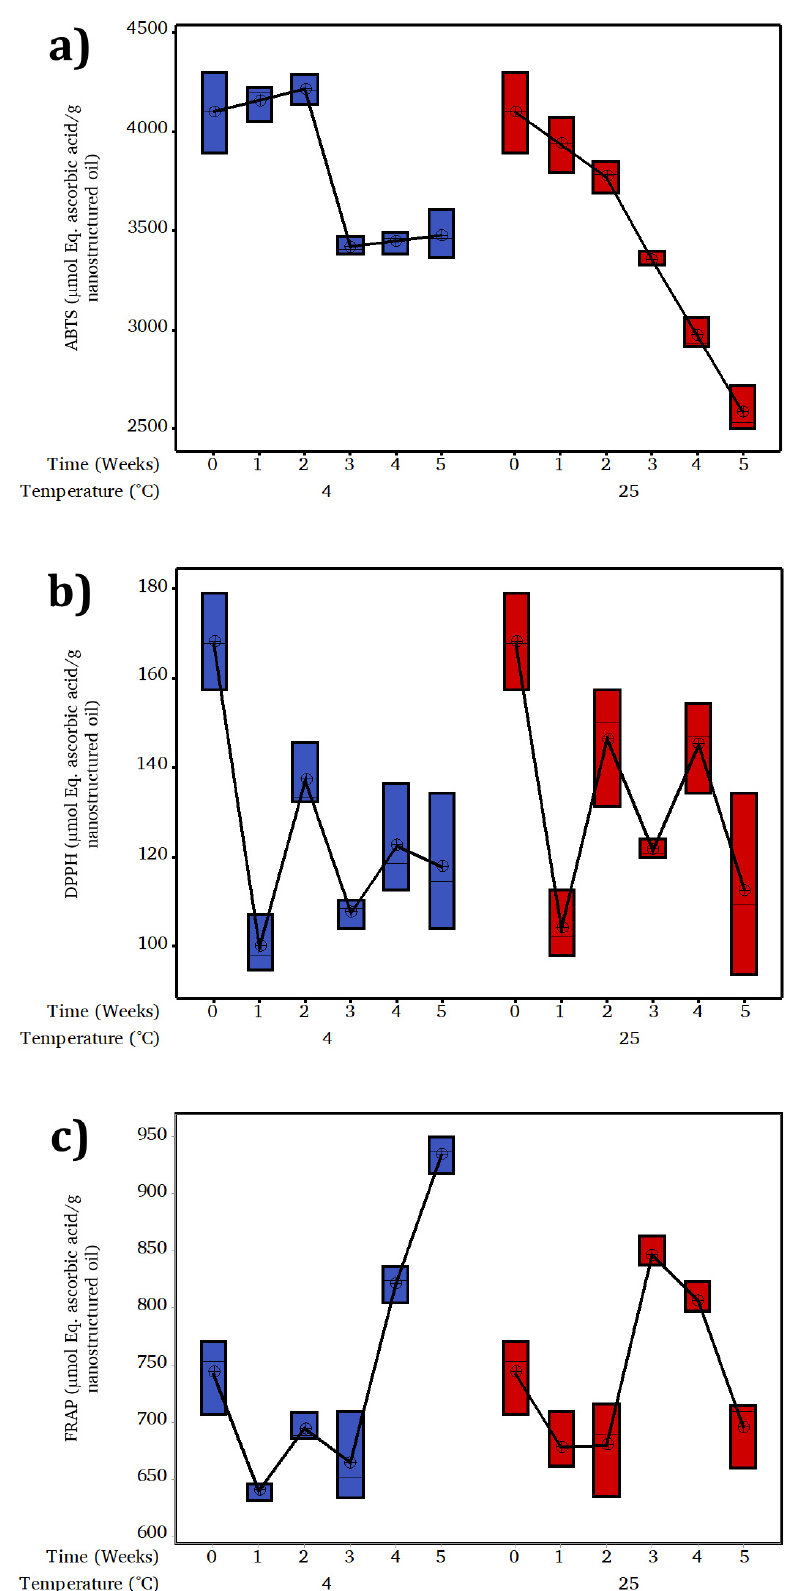
Figure 4. Evolution of antioxidant capacity by: ( a ) ABTS; ( b ) DPPH; and ( c ) FRAP of chitosan-thyme nanocapsules onto storage at 4 and 25 °C.